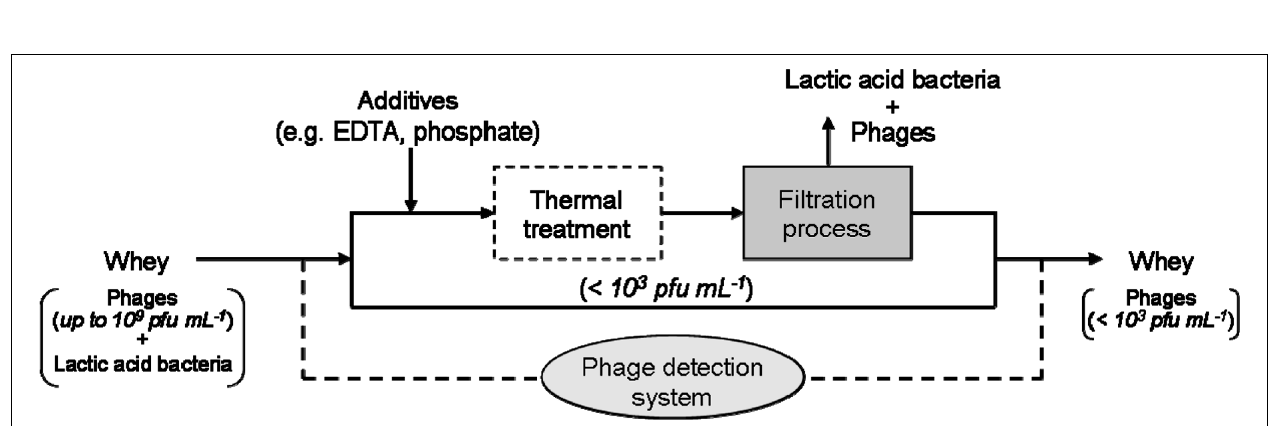
FIGURE 5 | Example for an application of combined treatments for phage elimination in